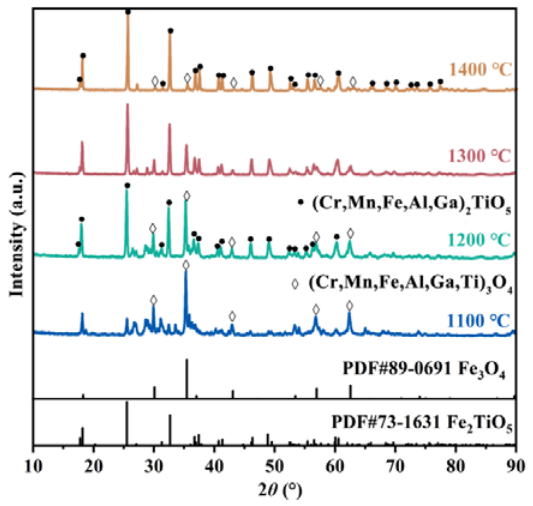
Fig. 5 XRD patterns of B2T after sintering at 1100, 1200, 1300, and 1400 ℃ for 2